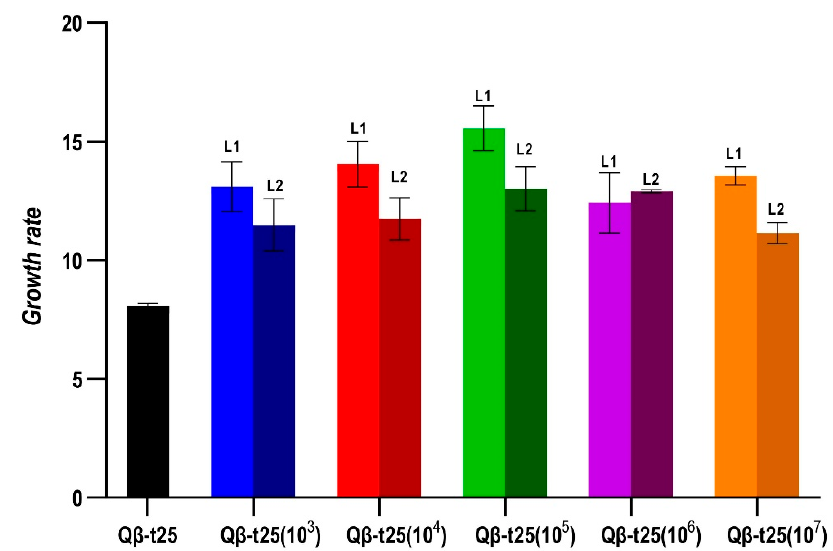
Figure 4. Growth rate values at 43 ◦ C obtained for the evolutionary lineages propagated from Q β -t25. The value obtained for the ancestor is also shown. Each bar represents the average of three replicas, and the error bars correspond to the standard